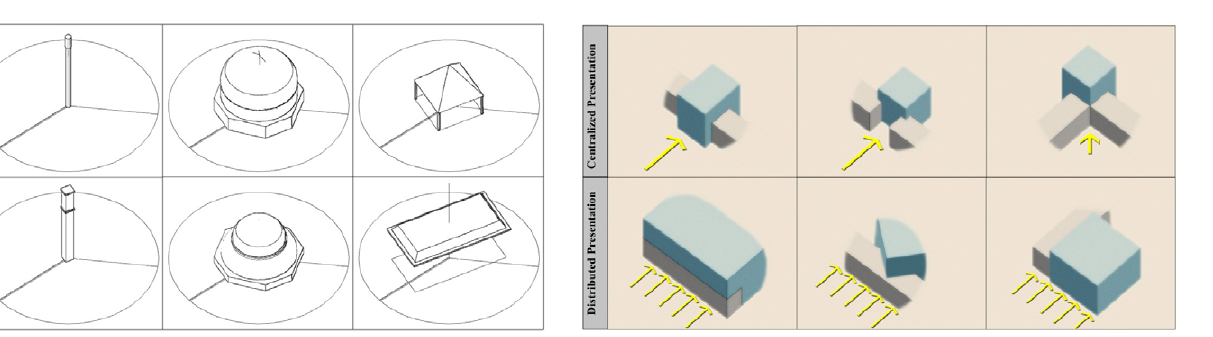
Figure 11. The modes of unit combinations are to present particular qualities on the sides of the civic